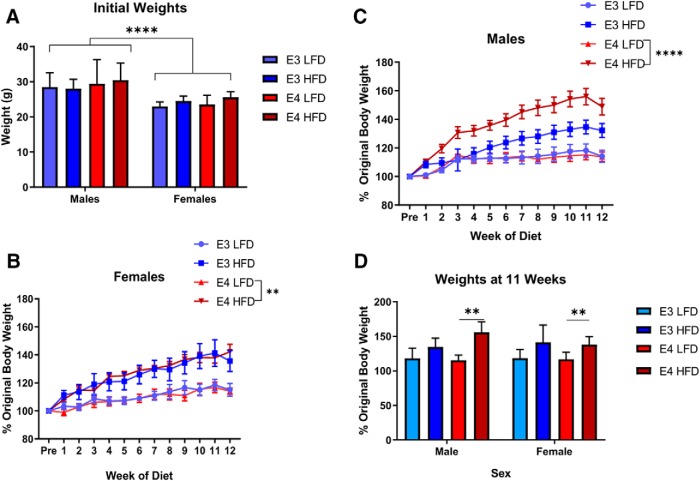

HFD increases weight gain and glucose intolerance. Weight gain comparison from pre-diet to week 12 on diet across APOE genotypes and sex. Initial weights of all mice in grams (A). Diet associated weight gain of female APOE3 and APOE4 mice (B) and male APOE3 and APOE4 mice (C). Direct comparison of male and female weight gain at week 11 on diet (D). E3 LFD: light blue, APOE3 mice on a LFD, E3 HFD: dark blue, APOE3 mice on a HFD, E4 LFD: light red, APOE4 mice on a LFD, E4 HFD: dark red, APOE4 mice on a HFD. Three-way ANOVA Tukey’s multiple comparison test, N = 5–9. A, ****p < 0.0001; B, **p < 0.003; C, ****p < 0.0001; D, **p < 0.0046.